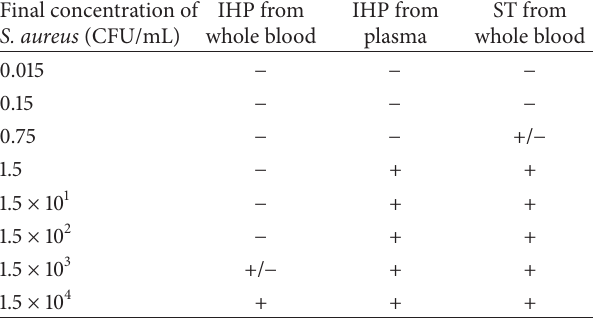
Table 1: Sensitivity of different detection methods in whole blood and plasma measured in samples spiked with S. aureus . IHP from plasma and ST from whole blood showed equal sensitivity. Reported is the strength of visible bands in gel electrophoresis (“+” strong band present, “+/ − ” weak band present, and “ − ” no band present). The identity of bands was confirmed by sequencing (ST = SepsiTest, IHP = in-house